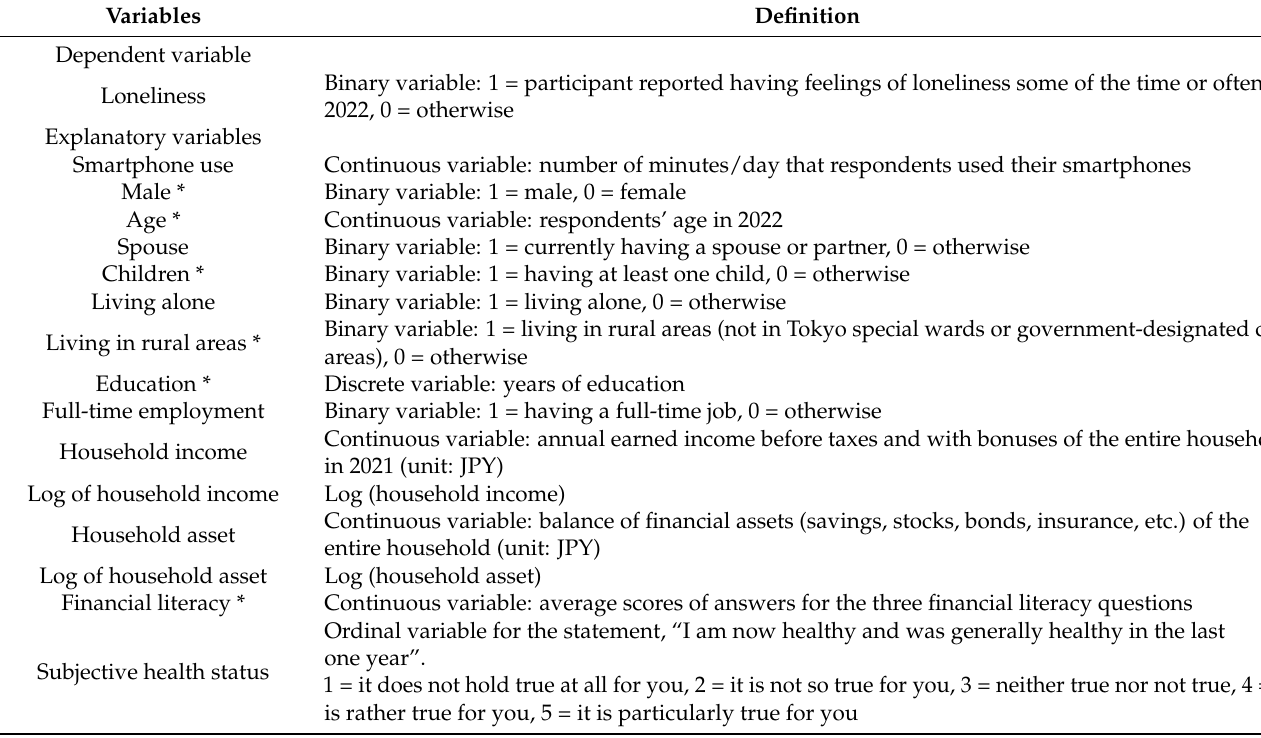
Table 1. Variable